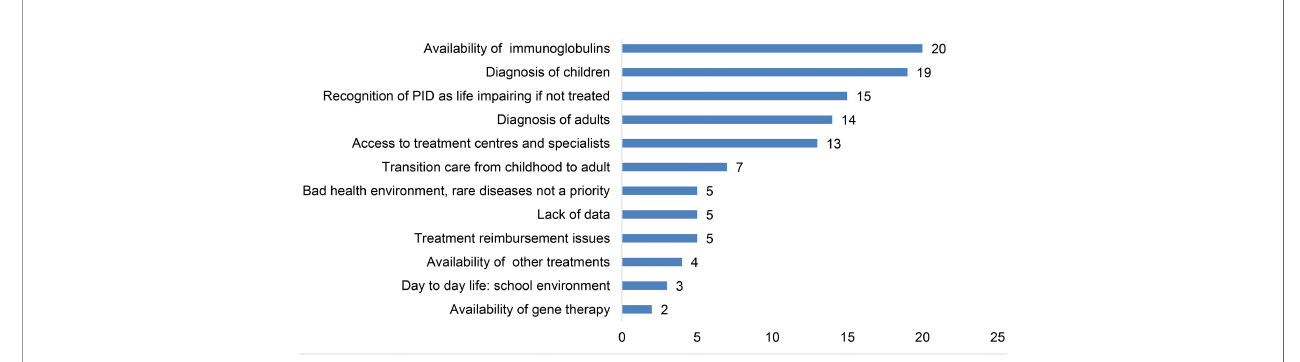
FIGURE 11 | Main areas of concern for PID patient organisations